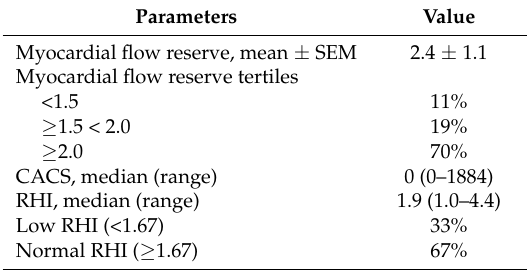
Table 2. HIV related data. Table 3. Data from the original 82 -rubidium study and the RHI from the present endoPAT ® study.